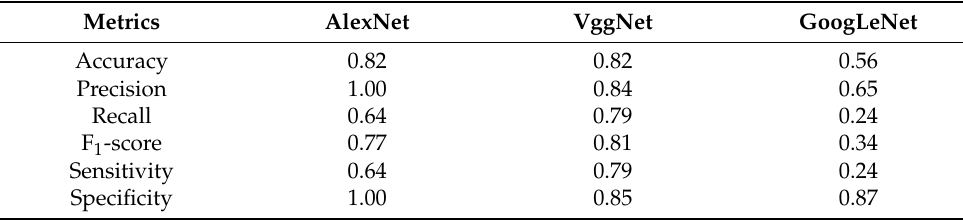
Table 6. Metric comparison under range change.